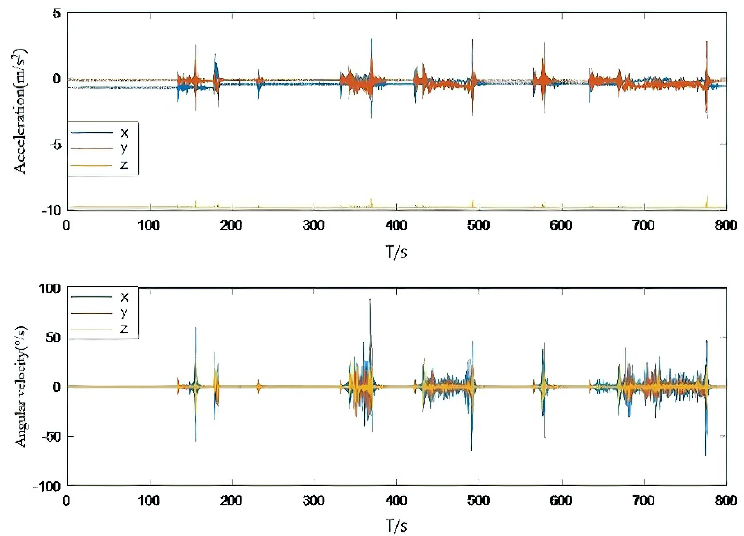
Figure 4. Attitude angle error of measured data . Table 2. Attitude angle calculation error. a. Attitude angle calculation error of IAE method Roll Angle